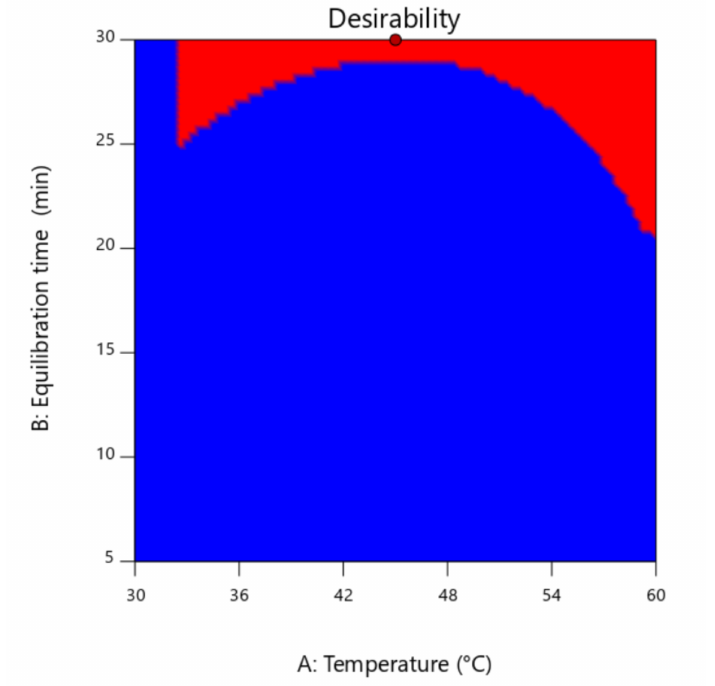
Figure 2. Desirability contour of equilibration time as a function of temperature of all